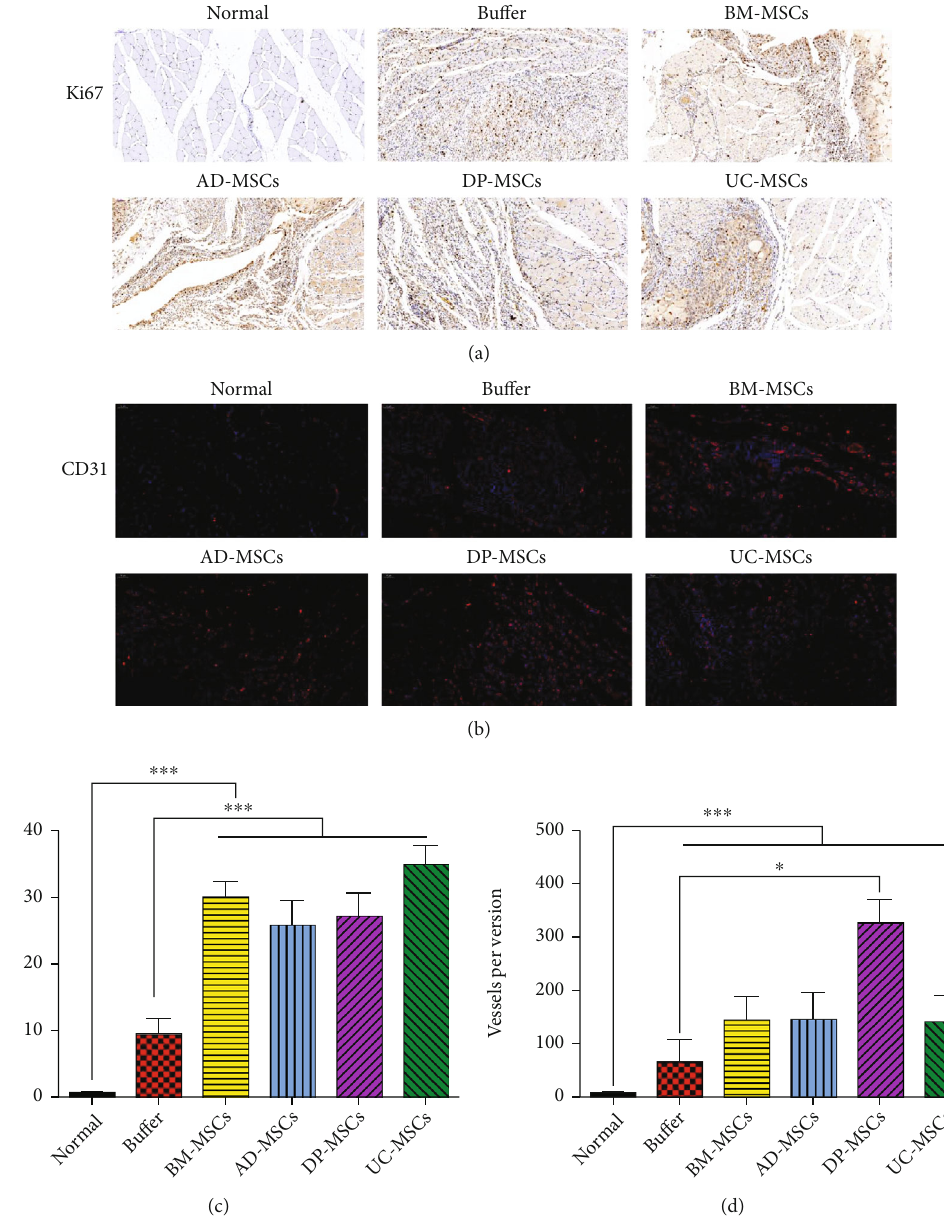
Figure 3: The proliferation of muscular tissues and formation of vascular lumens after treatments with MSCs. Four weeks after MSC transplantation, the muscular tissues in the ischemic area were collected, fi xed in 4% formaldehyde solution, and processed. The proliferation in ischemic areas was detected by Ki67 staining using immunohistochemistry. The representative images are shown in (a). To determine vessel formation, the sections were also analyzed by immuno fl uorescence using an anti-rat CD31 antibody. The representative images are presented in (b). Moreover, the proliferative index and the percentage of Ki67 + cells were calculated (c), and the number of vascular lumens was counted (d). Data in (c) and (d) were shown as mean ± s : e : m . ∗ p < 0 : 05 , ∗∗∗ p < 0 : 001 compared with the corresponding